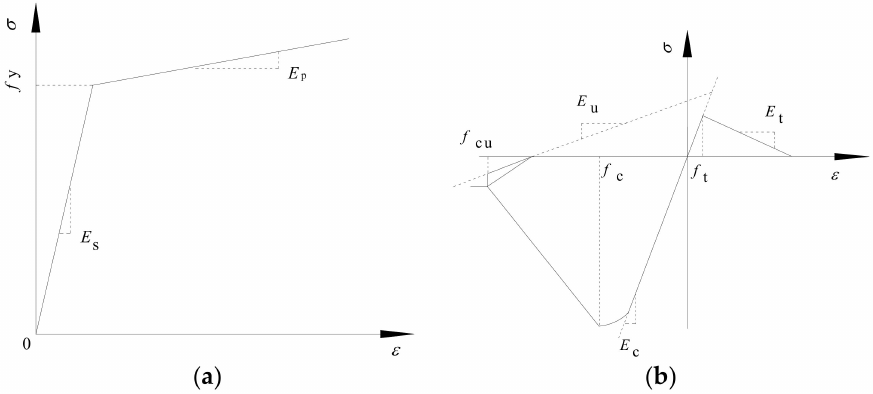
Figure 7. Constitutive model of materials: ( a ) constitutive model of steel and ( b ) constitutive model of concrete.